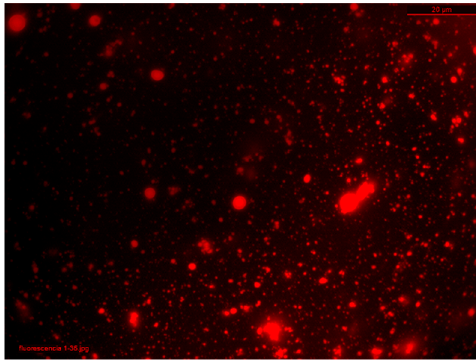
Figure 8. Microscopy images (x100) of AL-CS nanoemulsion prepared with sacha inchi: fluorescence filter TX2:BP 560/40 (red color corresponds to sacha inchi oil stained with Nile red).